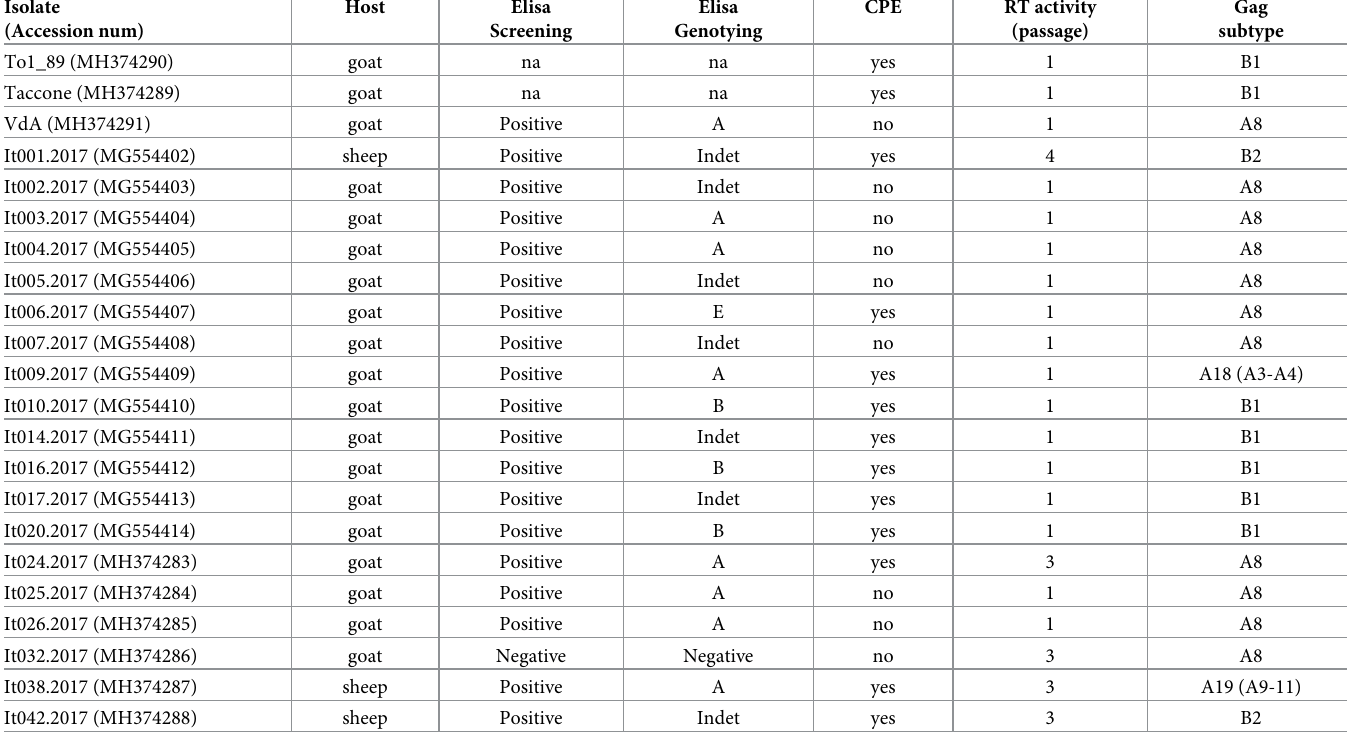
Table 1. Samples characterized in the present